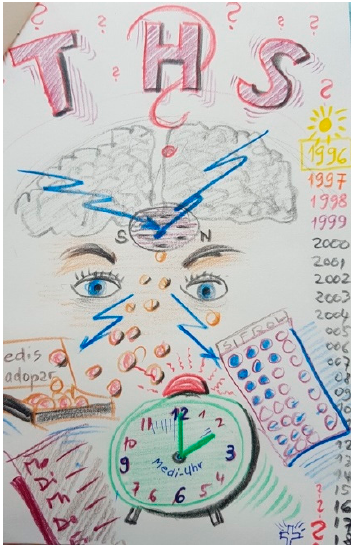
Figure 16. FC26’s perception of DBS’s